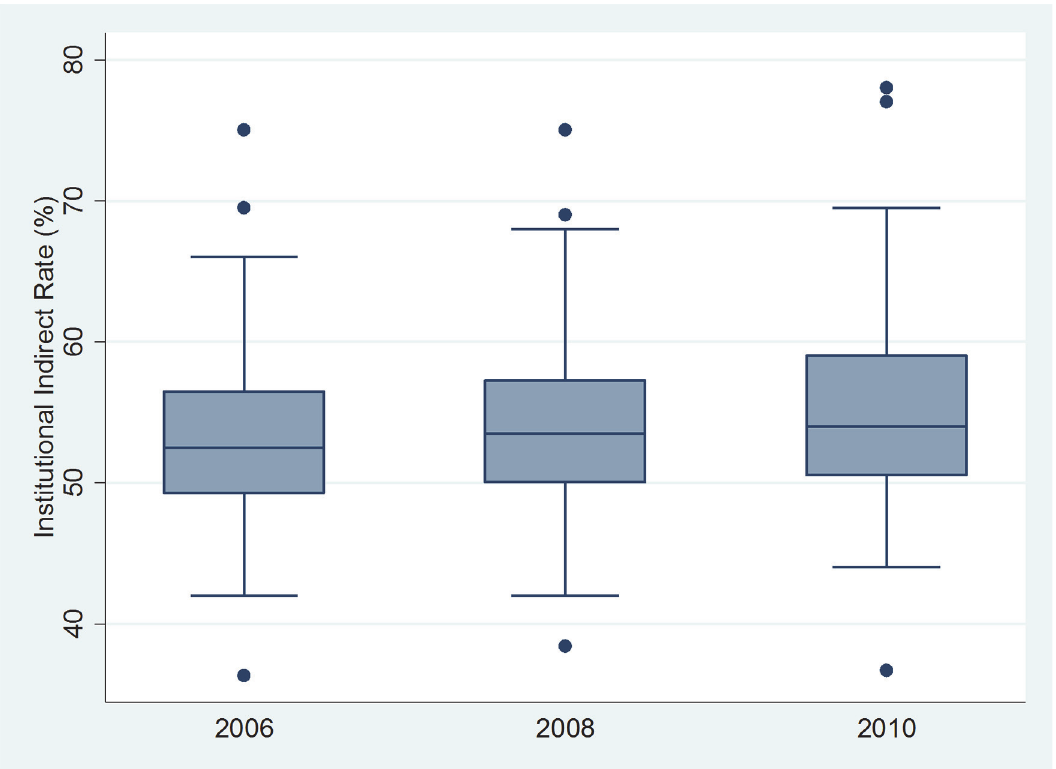
Fig 1. Distribution of institutional indirect rates by year. Boxes encompass 25 th to 75 th percentiles with whiskers showing nearest adjacent values and outliers displayed as dots.